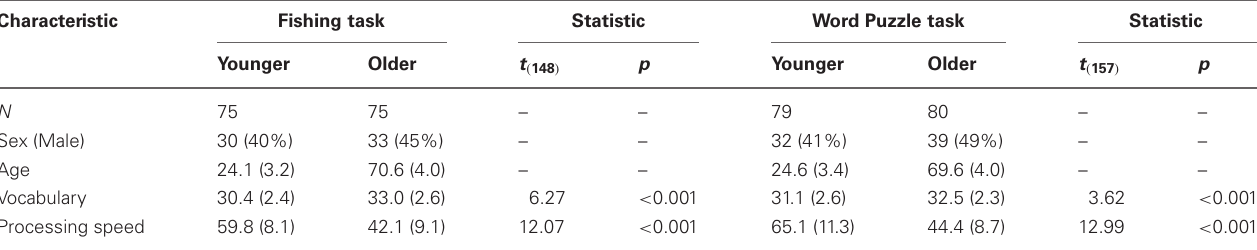
Table 2 | Participant